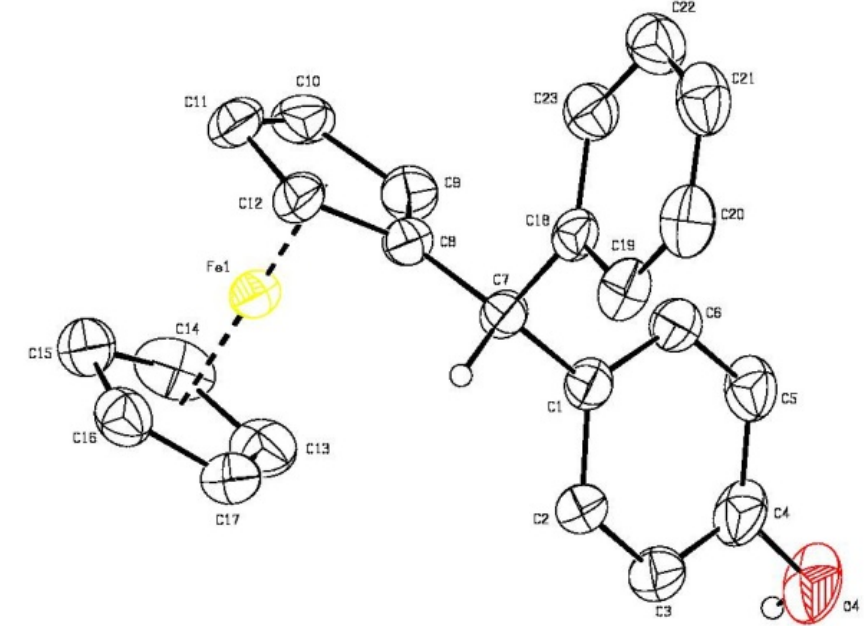
Figure 3. X-ray structure of ferrocene derivative 3a . Thermal ellipsoids are drawn at the 30% probability level. Hydrogen atoms are excluded, except those bonded to C7 (H7) and O4 (H4O).